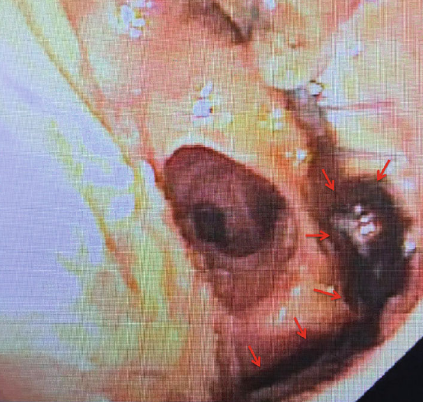
Figure 5: Repeat bronchoscopy 32 days posttransplantation showed right mainstem bronchial anastomotic site dehiscence (red